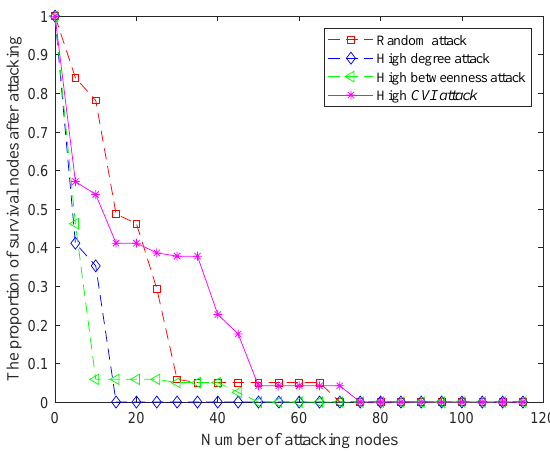
Figure 12. Nodes survived under different